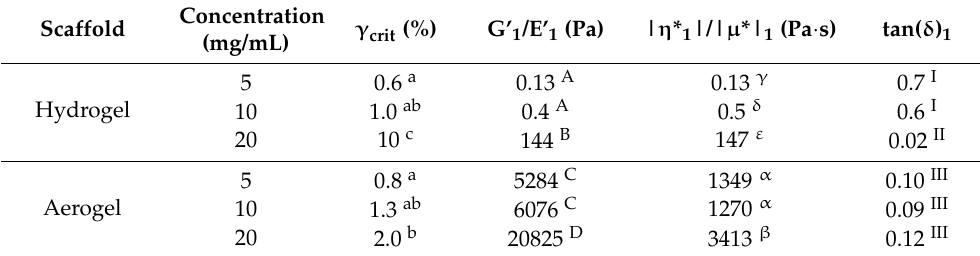
Table 1. Critical strain, elastic modulus, complex viscosity, and loss tangent at 1 Hz (G (cid:48) 1 , tan δ 1, and η * 1 ) of collagen-based hydrogels and aerogels at different collagen concentrations (5, 10, and 20